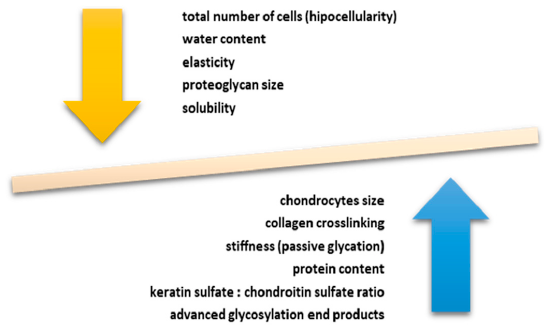
Figure 2. Main changes in articular cartilage due to aging process. Aging is responsible for the senescence of chondrocytes and for the specific modifications that appear in the structure of the cartilage. The anabolic processes are slowed down, and the catabolic ones accelerated. Significant changes in cell phenotype have been observed. Cells modification of the normal shape with a flattened one, altered secretory capacity and synthesis of collagen type X has been noted. A decrease in specific secretion products, such as glycoproteins, proteoglycans or type II collagen, was also highlighted. The aging of articular cartilage is characterized by a decrease in cellularity, dehydration, decreased elasticity and solubility, and decreased proteoglycan molecule sizes. On the other hand, an increase in chondrocyte size, cartilage stiffness, protein content and glycosylation products were observed.